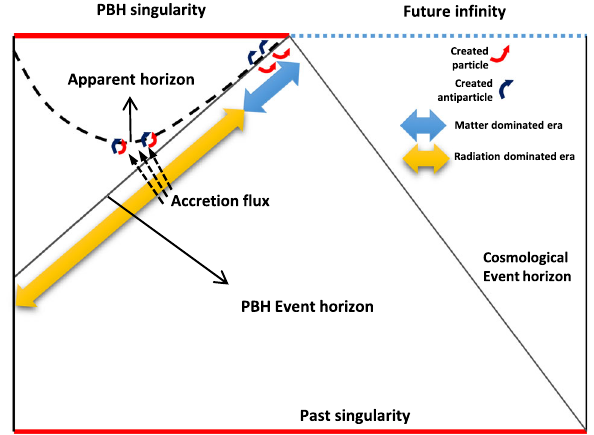
Fig. 1 Penrose diagram for a primordial black hole in a (cid:9) CDM expanding universe, where there is some matter and radiation accre- tion flux, but it dies away to zero in the far future (matter-dominated era). Note that we do not represent backreaction effects in this picture. Thus, the black hole dynamical horizon tends to be event horizon in the matter-dominated